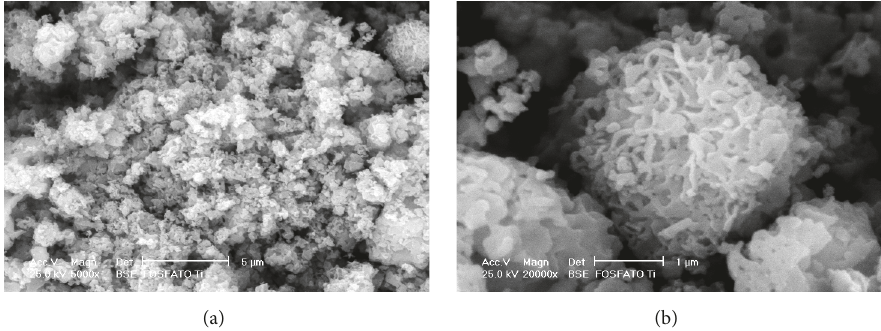
Figure 2: (a) Micrograph obtained at 5000x magnification, where polymorphic particles of laminar appearance could be observed (3 𝜇 m). (b) Micrograph obtained at 20000x magnification, where spherical particles of irregular surface are observed (2 𝜇